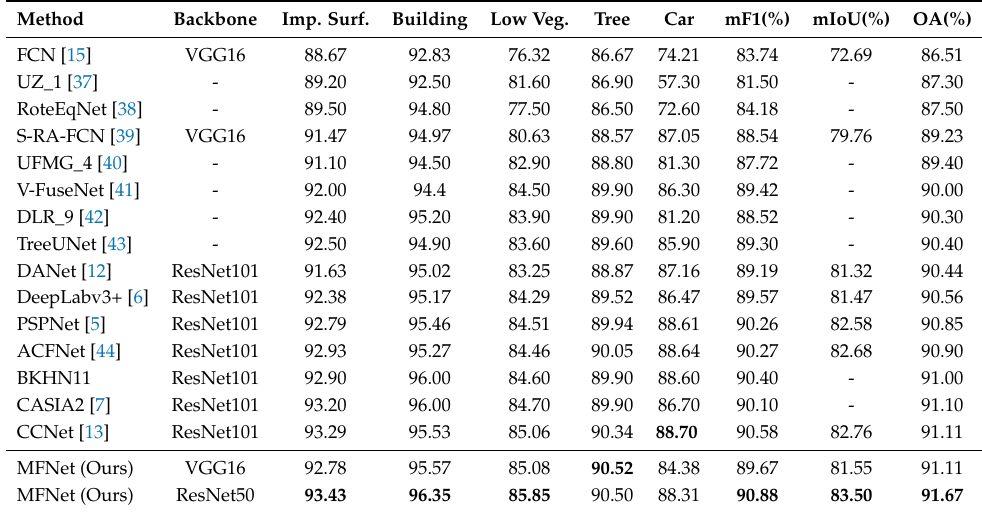
Table 7. Comparisons with state-of-the-art on Vaihingen test set. Method